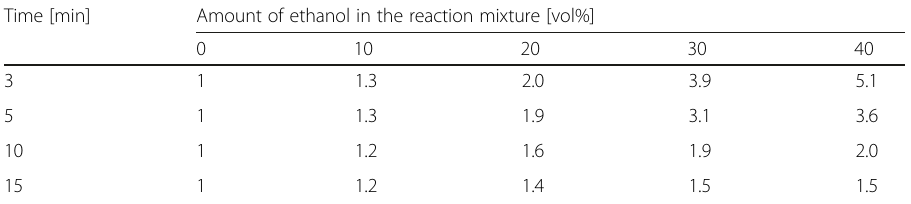
Table 1 Increase of 68 Ga-DOTATOC labeling yields depending on the reaction period by factor. The dramatic increase for short reaction periods such as e.g. 5 min is highlighted in grey Time [min] Amount of ethanol in the reaction mixture [vol%]